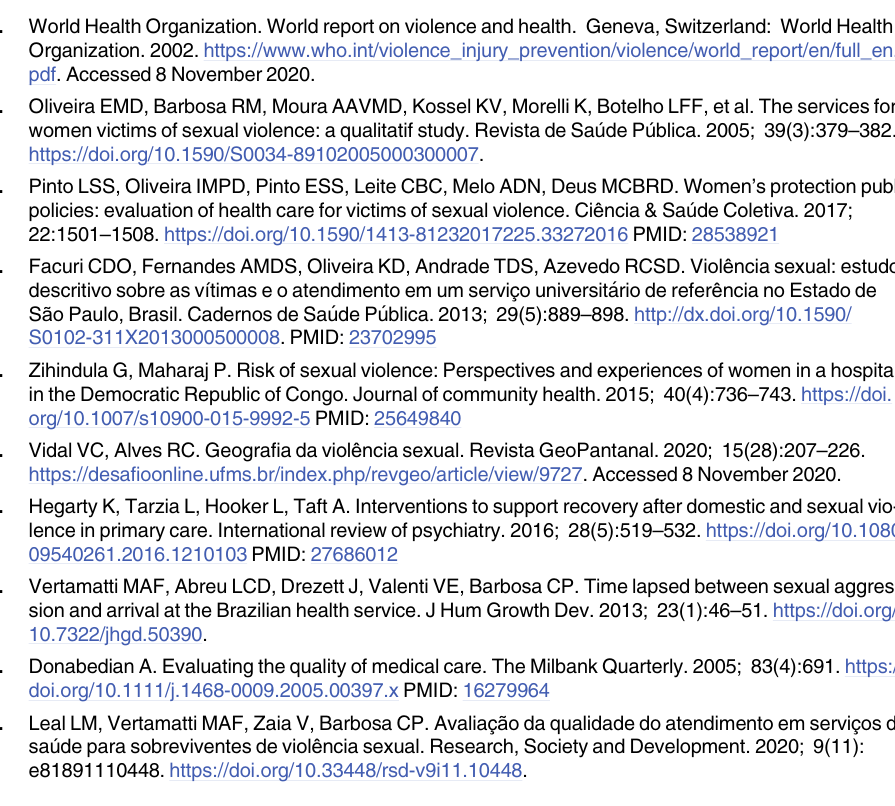
S5 Table. Structure evaluation